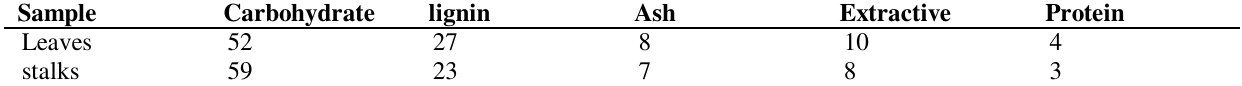
The composition of date palm fronds (leaves and stalk) based on dry weight Wt